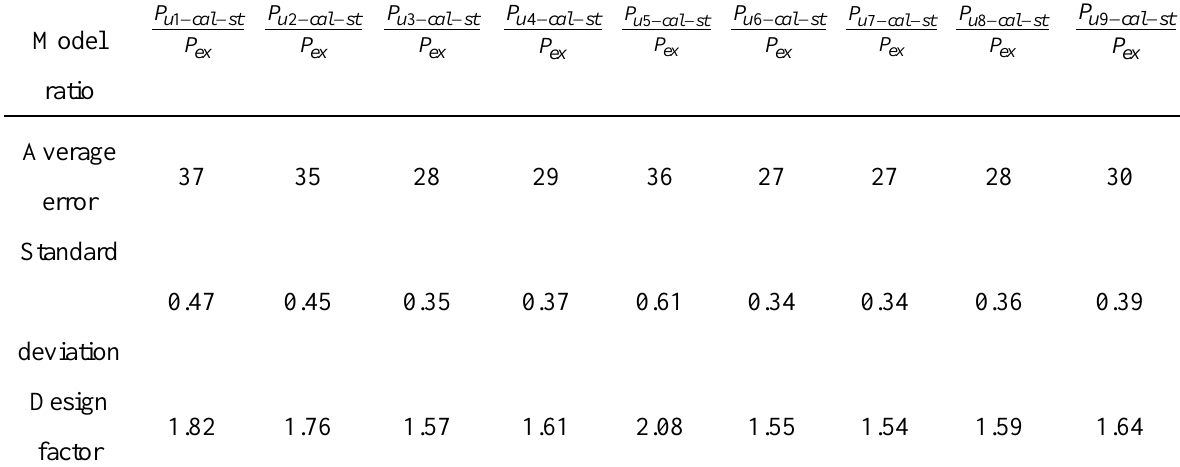
Table 8. Probabilistic results for the calibrated models for "COV = 20%" without any correlation between the random